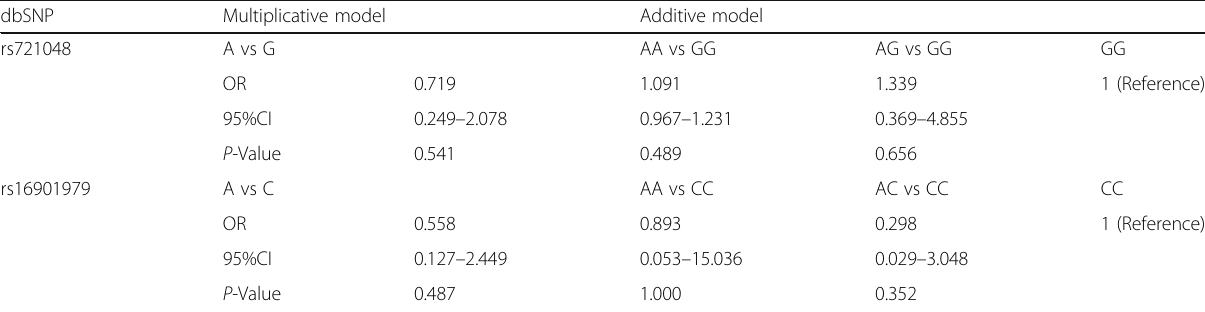
Table 3 Multiplicative and additive genetic models dbSNP